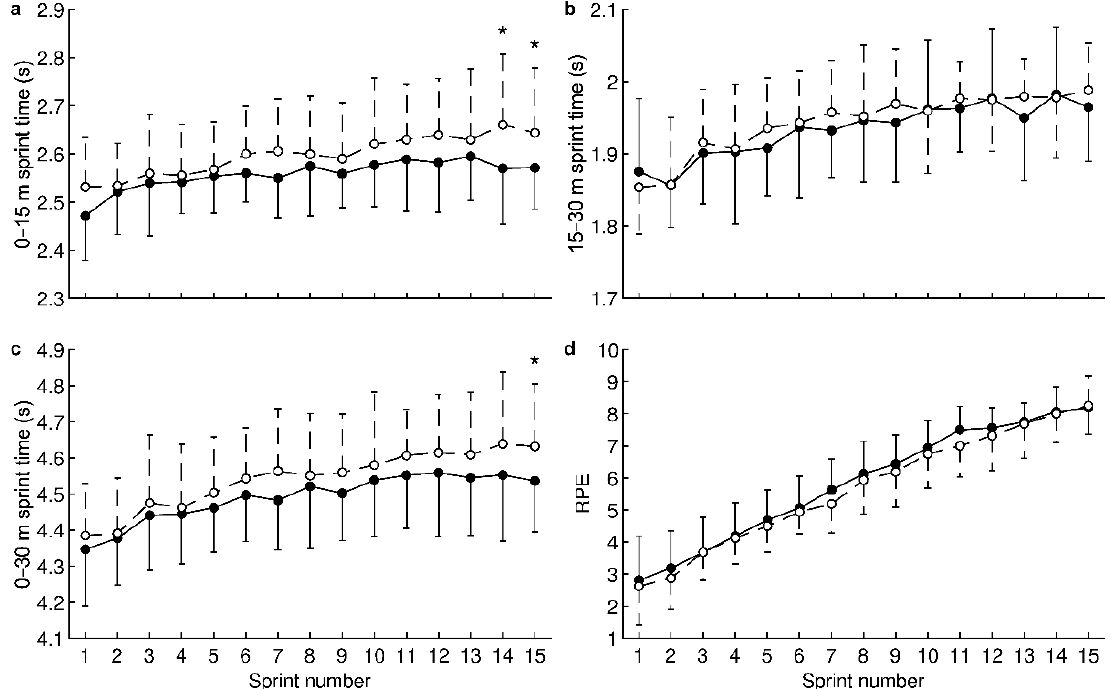
Figure 2. Effect of hydrogen-rich water on sprint time for the first half of the track ( a ); sprint time for the second half of the track ( b ); sprint time for the entire track ( c ); and rating of perceived exertion ( d ). ● —hydrogen-rich water; ○ —placebo; ⋆ —statistically significant ( p < 0.025, Holm–Bonferroni method) difference between hydrogen-rich water and placebo. Values are presented as the mean and standard deviation.